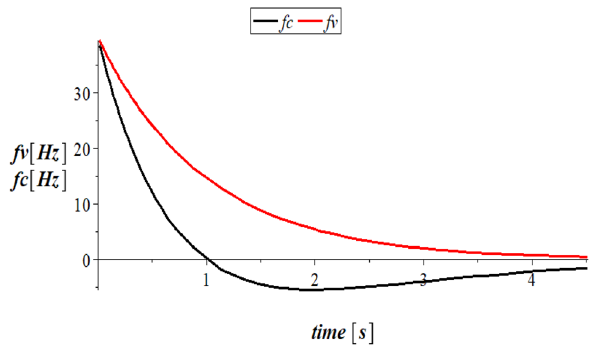
Fig. 17 Frequency of the voltage f v 3 ( t ) and dynamic frequency of current f c 3 ( t ) , for exponential decrease ( T = 0.075 (s) ) of voltage frequency from f 0 = 40 (Hz) to f k = 0 (Hz)